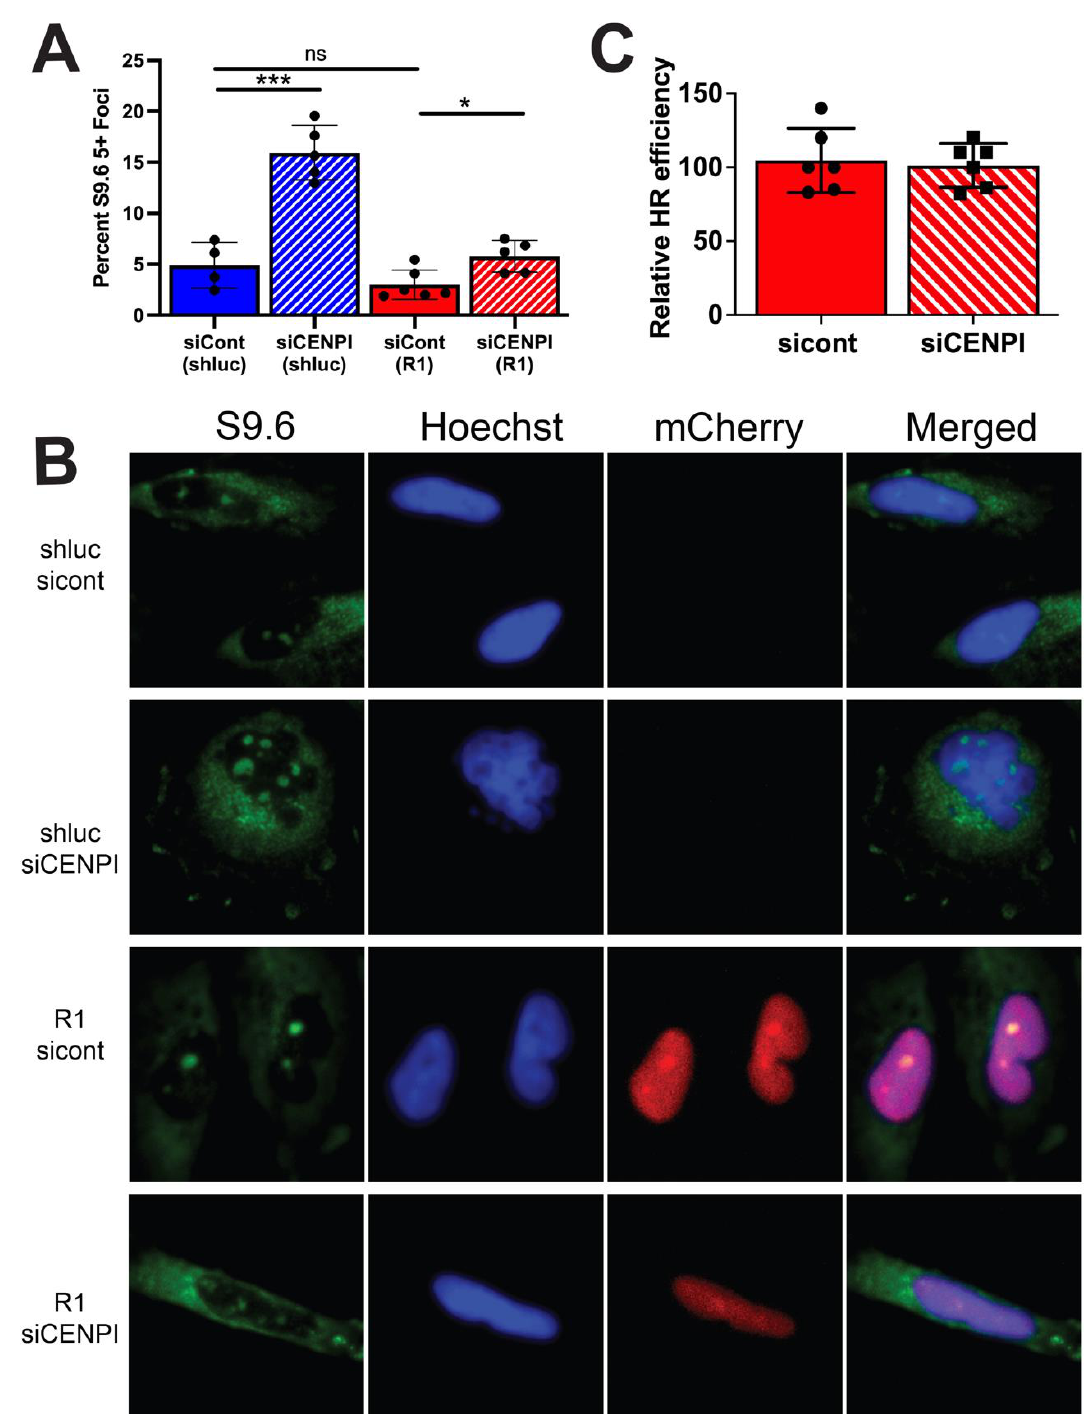
Figure 6. Loss of CENP-I results in RNA:DNA hybrid formation. ( A , B , Supplemental Figure S6) Formation of S9.6 nuclear foci was examined in LN229 control (luc) and LN229 RNaseH1 expressing (R1) cells transfected with control (cont) or CENP-I siRNAs. For each experiment, at least 500 cells were examined. ( C ) Homologous recombination (HR) repair efficiency was measured in the DR U2OS reporter cell lines expressing exogenous RNaseH1 exposed to control (cont) or CENP-I siRNA. For each experiment, HR repair efficiency was determined by counting 10,000 cells per condition and normalizing to sicont-treated cells. Statistical analysis was performed using a Student’s t -test. * = p < 0.05, *** = p ≤ 0.0001.